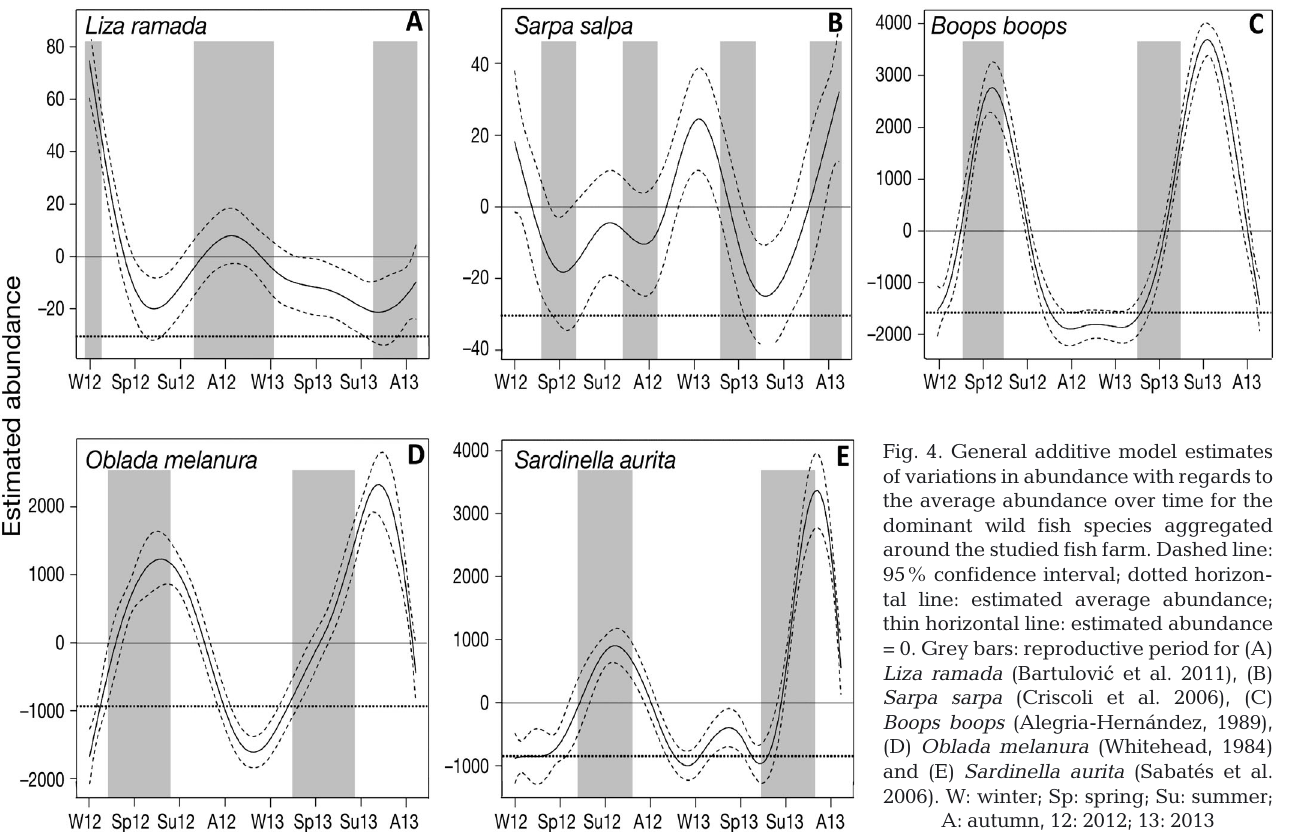
Fig. 4. General additive model estimates of variations in abundance with regards to the average abundance over time for the dominant wild fish species aggregated around the studied fish farm. Dashed line: 95% confidence interval; dotted horizon- tal line: estimated average abundance; thin horizontal line: estimated abundance = 0. Grey bars: reproductive period for (A) Liza ramada (Bartulovi ć et al. 2011), (B) Sarpa sar pa (Criscoli et al. 2006), (C) Boops boops (Alegria-Hernández, 1989), (D) Ob la da melanura (Whitehead, 1984) and (E) Sardinella aurita (Sabatés et al. 2006). W: winter; Sp: spring; Su: summer; A: autumn, 12: 2012; 13: 2013